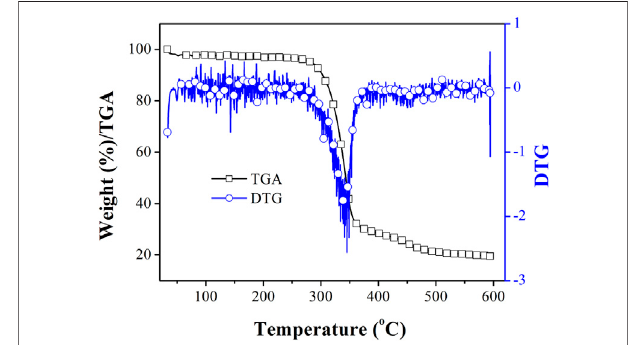
FIGURE 1 | TGA and DTG curves of Eu (N-DPNQ) (TTD) 3 .